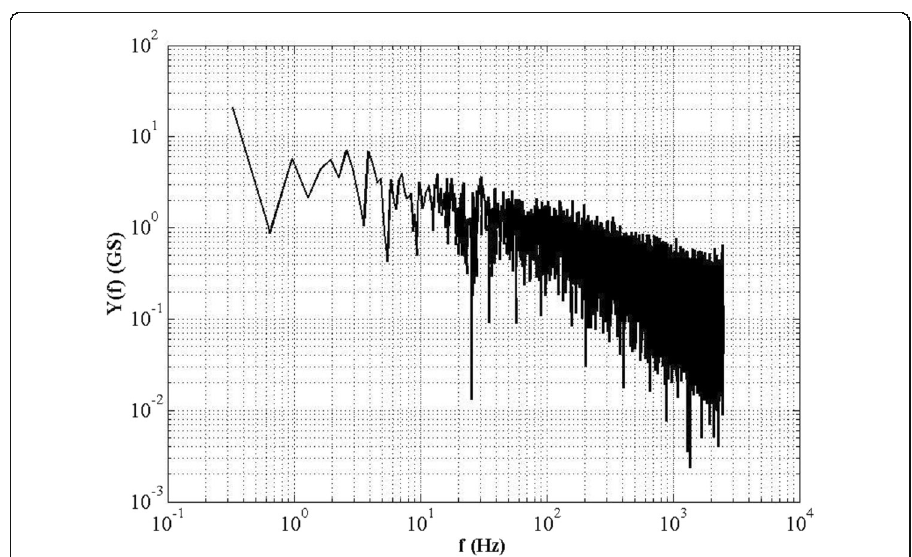
Fig. 3 Grayscale spectral energy distribution before smoothing, for the data associated with pixel [736, 329] on the shock wave of the test on 13 November 2017. The spectrum is representative of unsmoothed grayscale spectral energy distribution data